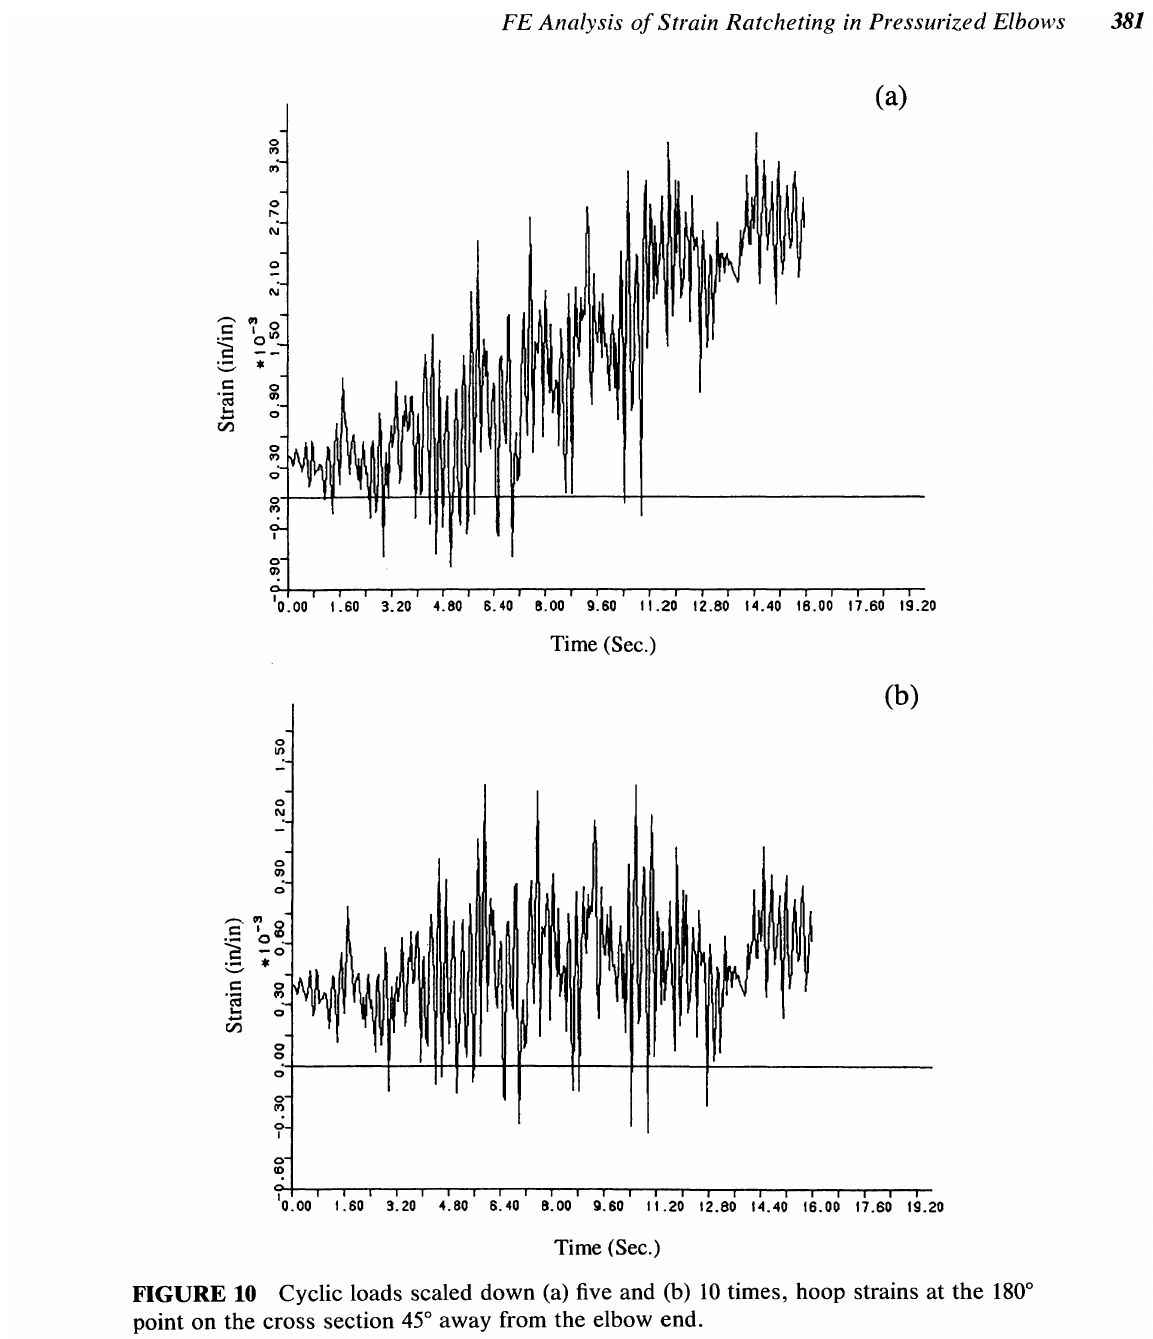
FIGURE 10 Cyclic loads scaled down (a) five and (b) 10 times, hoop strains at the 180 0 point on the cross section 45 0 away from the elbow